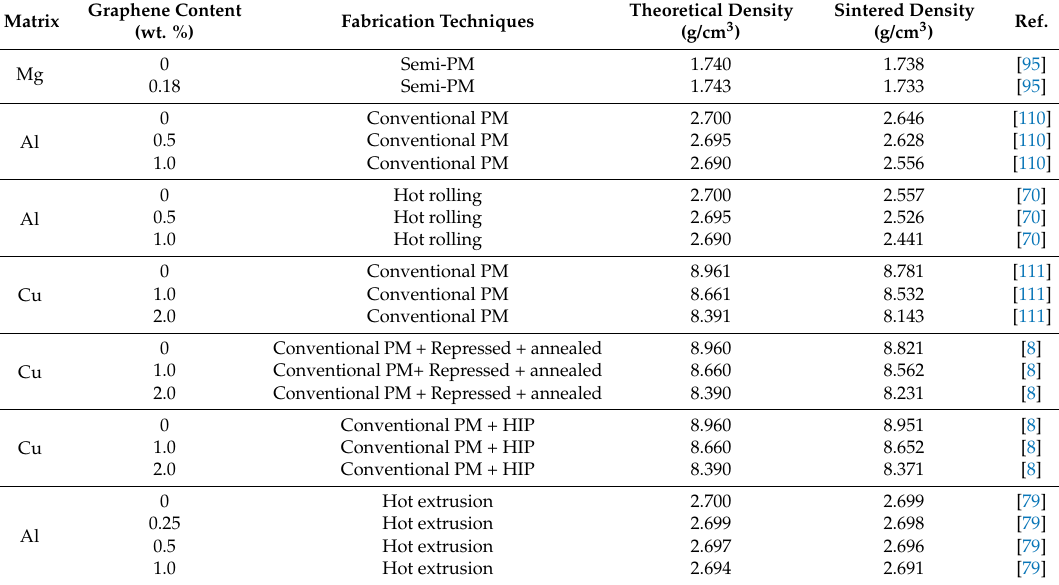
Table 4. Theoretical and sintered density of MMNCs reinforced with graphene nanoplatelets. Graphene Content Matrix (wt.